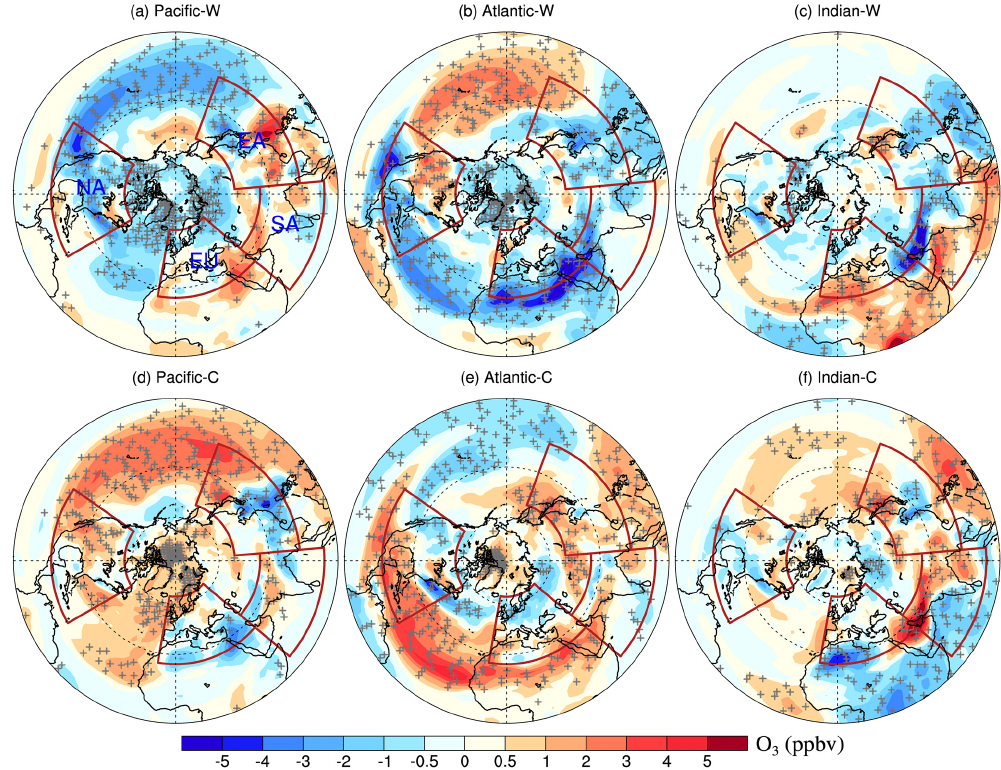
Figure 1. Changes in the summertime (June–August) surface O 3 concentrations (ppbv) in the Northern Hemisphere induced by 1 ◦ C warm- ing (a, b, c) and 1 ◦ C cooling (d, e, f) in the North Pacific Ocean (a, d) , North Atlantic Ocean (b, e) , and North Indian Ocean (c, f) relative to the CTRL. The four major regions of interest (i.e., NA: 15–55 ◦ N, 60–125 ◦ W; EU: 25–65 ◦ N, 10 ◦ W–50 ◦ E; EA: 15–50 ◦ N, 95–160 ◦ E; and SA: 5–35 ◦ N, 50–95 ◦ E) are marked with red polygons. The + symbols denote areas in which results are significant at the 0.05 level, evaluated using the Student’s t test and 20 years of